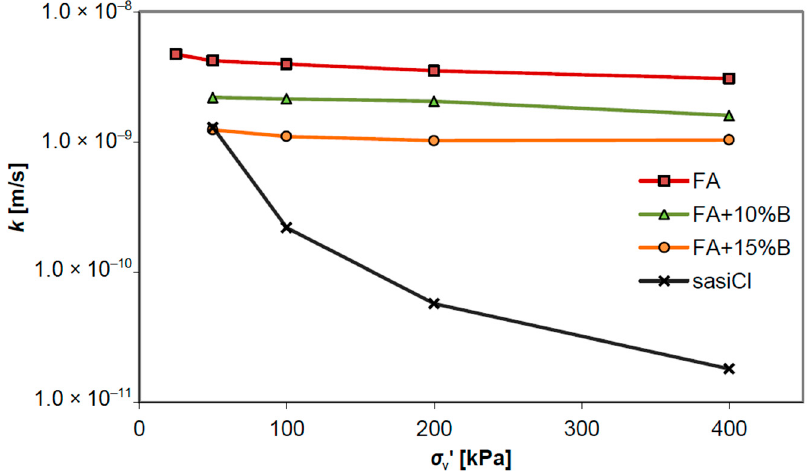
Figure 10. Hydraulic conductivity of sandy silty clay, fly ash and fly ash-bentonite mixes in the relation to effective stress at hydraulic gradient i = 32.